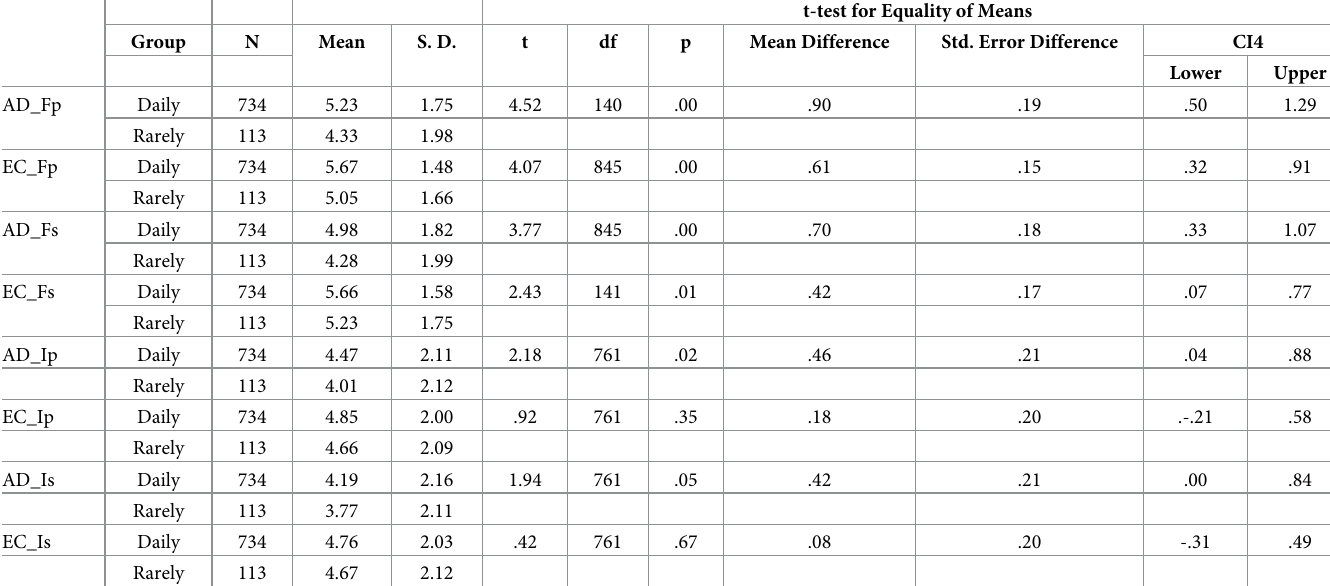
Table 4. Significant t-test results: Facebook/Instagram scale–daily use/rarely